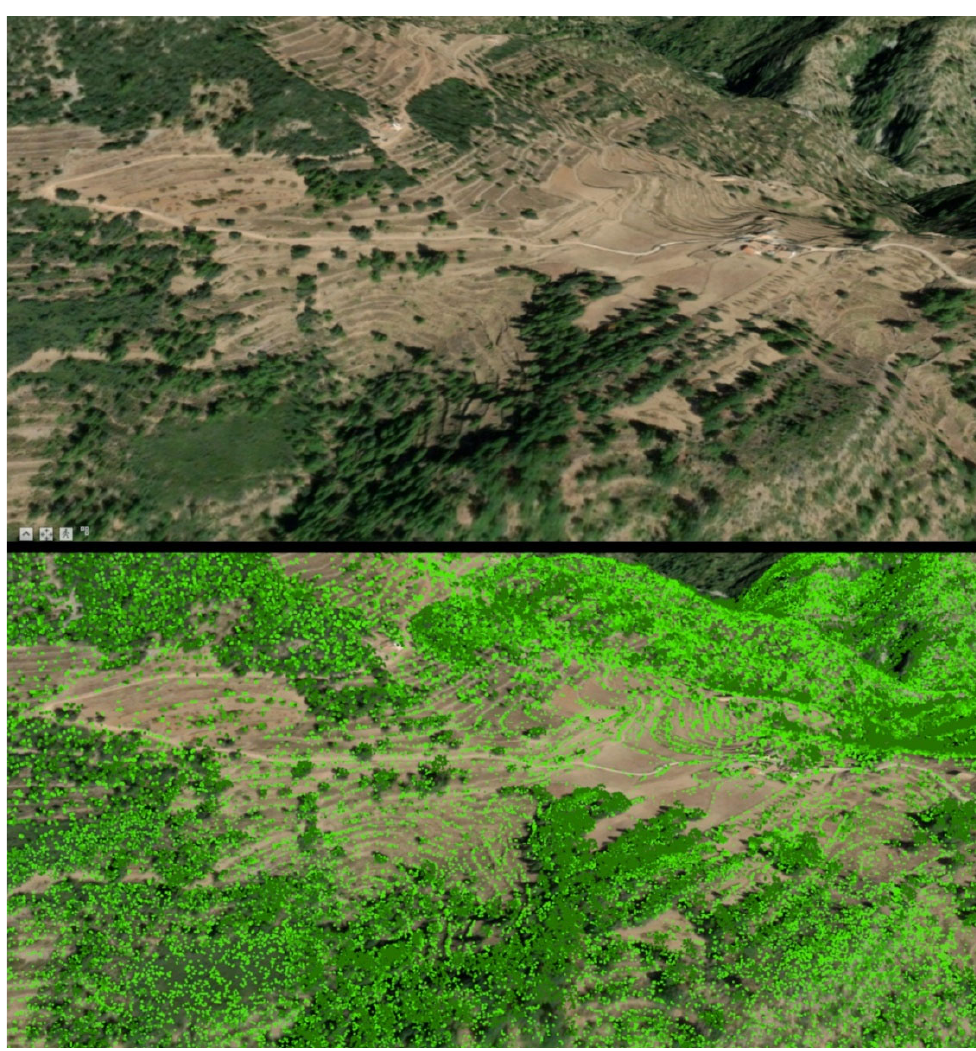
Figure 5. Orthophoto and LiDAR point clouds used for vegetation analysis. Source: authors.